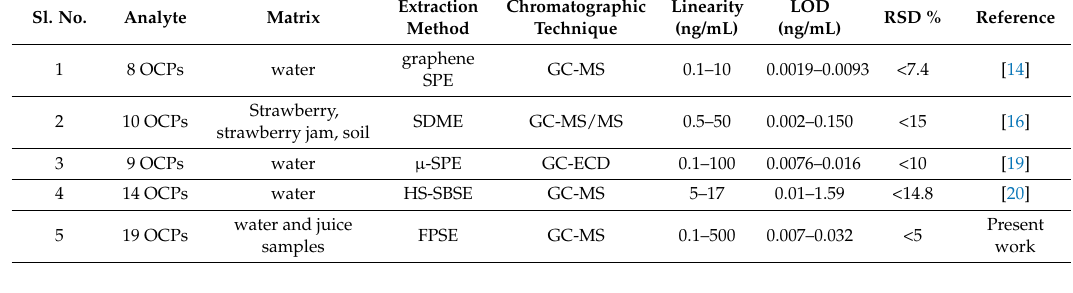
Table 4. Performance comparison between FPSE/GC-MS with other reported methods used in preconcentration and determination of organochlorine pesticides analytes. Sl.